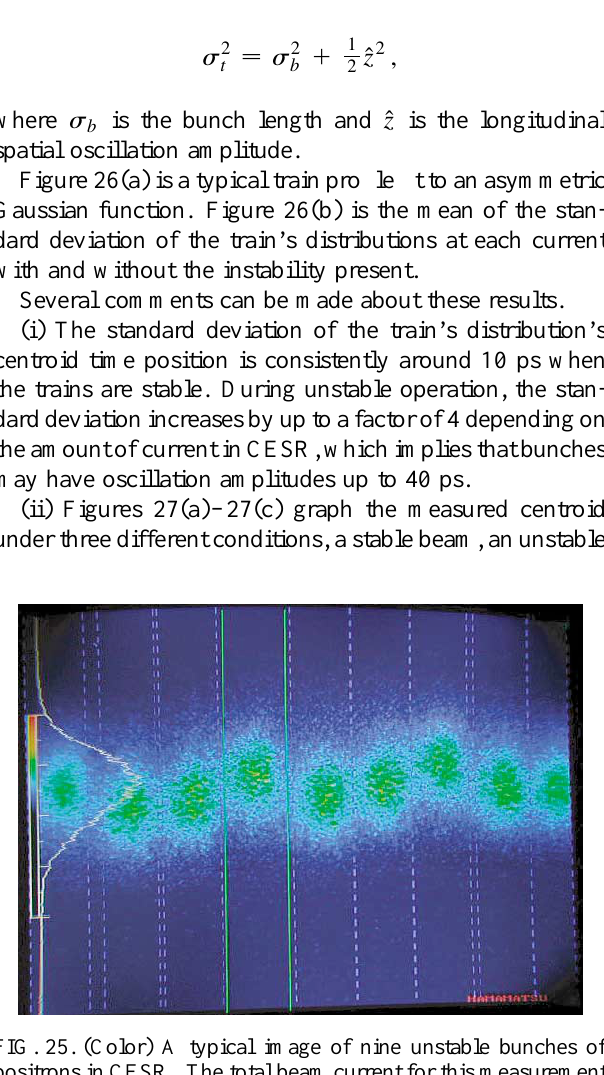
FIG. 25. (Color) A typical image of nine unstable bunches of positrons in CESR. The total beam current for this measurement was 184 mA.